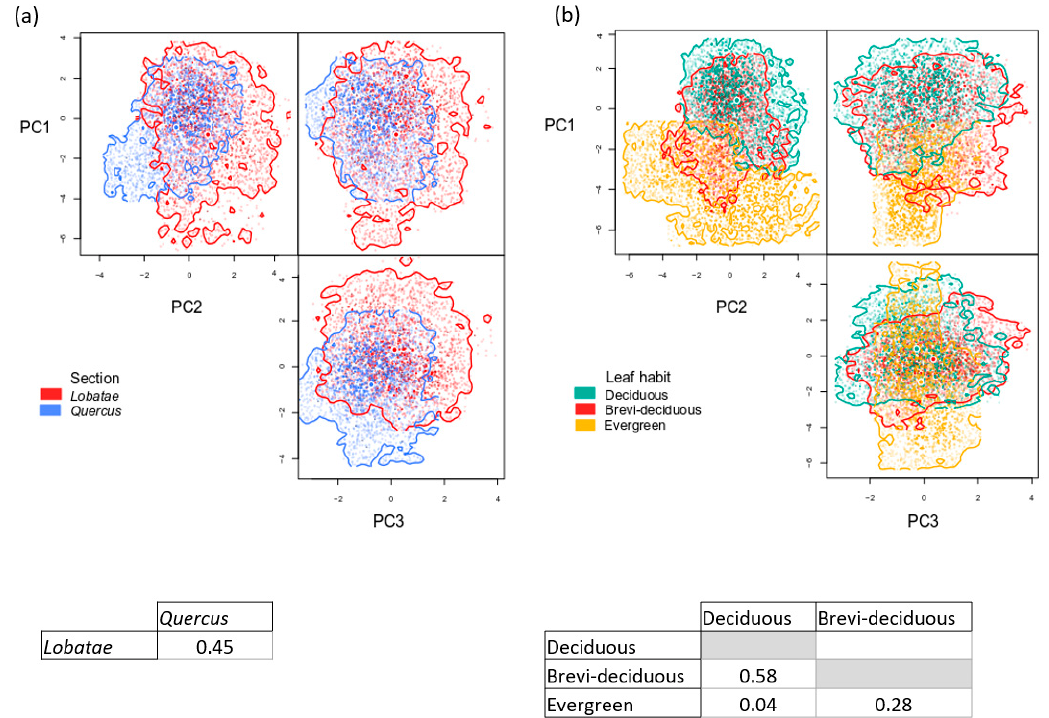
Figure 3. Functional hypervolumes and Sørensen functional similarity index among hypervolumes.